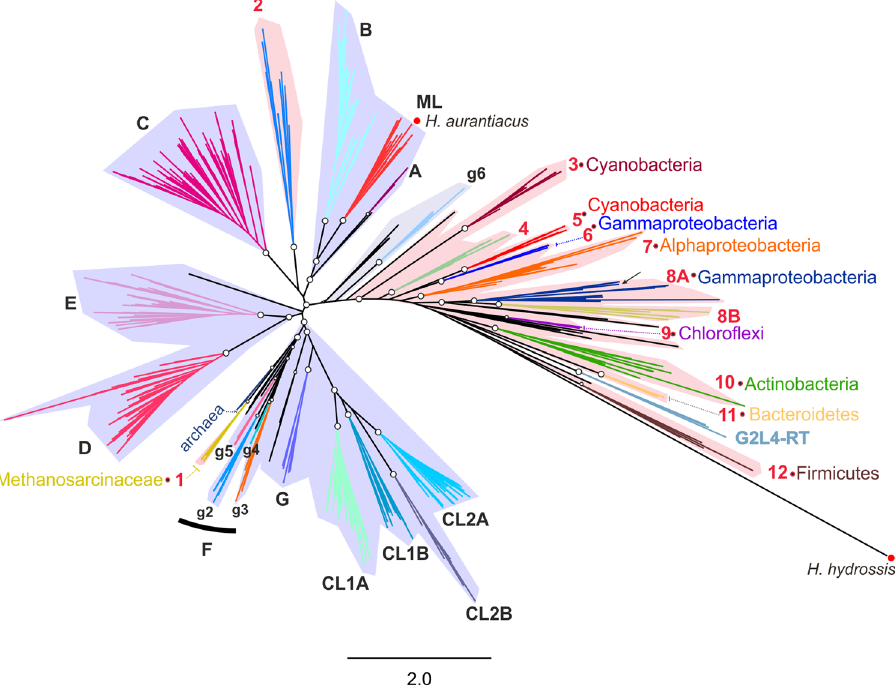
Figure 1. Unrooted phylogenetic tree encompassing the diversity of RTs associated with CRISPR-Cas systems. The tree includes 118 RT sequences associated with CRISPR-Cas systems and 419 closely related RT sequences (Methods). Note that the RTs associated with CRISPR-Cas 21 (highlighted with red dots) from Herpetosiphon aurantiacus (GI: 159898445) and Haliscomenobacter hydrossis (GI: 332661943) correspond to a group II intron and a retron/retron-like RT, respectively. The arrow indicates the position of the M . mediterranea (MMB-1) RT. Group II intron classes and varieties are highlighted in color and their names are indicated in black. All group II introns RTs are shadowed in light purple. The RT clades associated with CRISPR- cas loci are highlighted in color and their names are indicated in red. All RTs associated with CRISPR-Cas systems are shadowed in light pink. Open circles at the nodes indicate that the node concerned has a FastTree support value ≥ 0.92. The phyla restricted to particular RT-CRISPR clades are